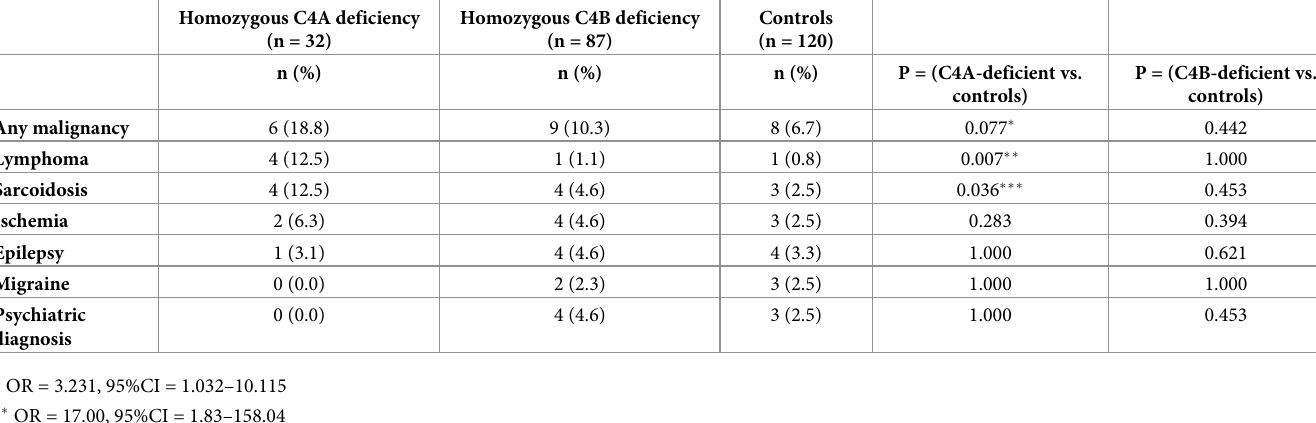
Table 3. Other clinical conditions associated with homozygous C4